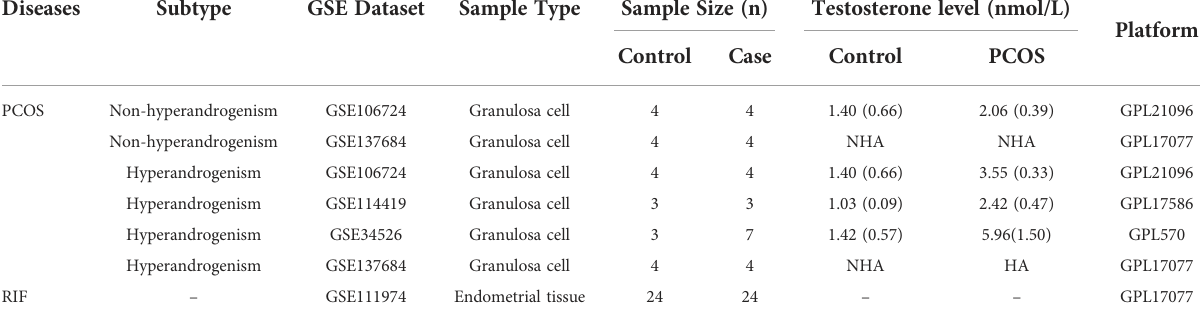
TABLE 1 Information of GSE